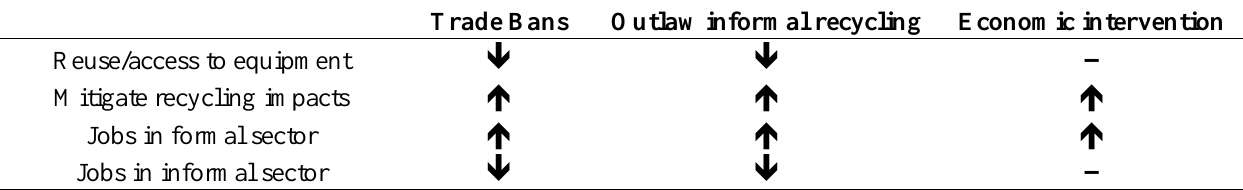
Table 1. Environmental, social and economic trade-offs for different policy interventions to address informal